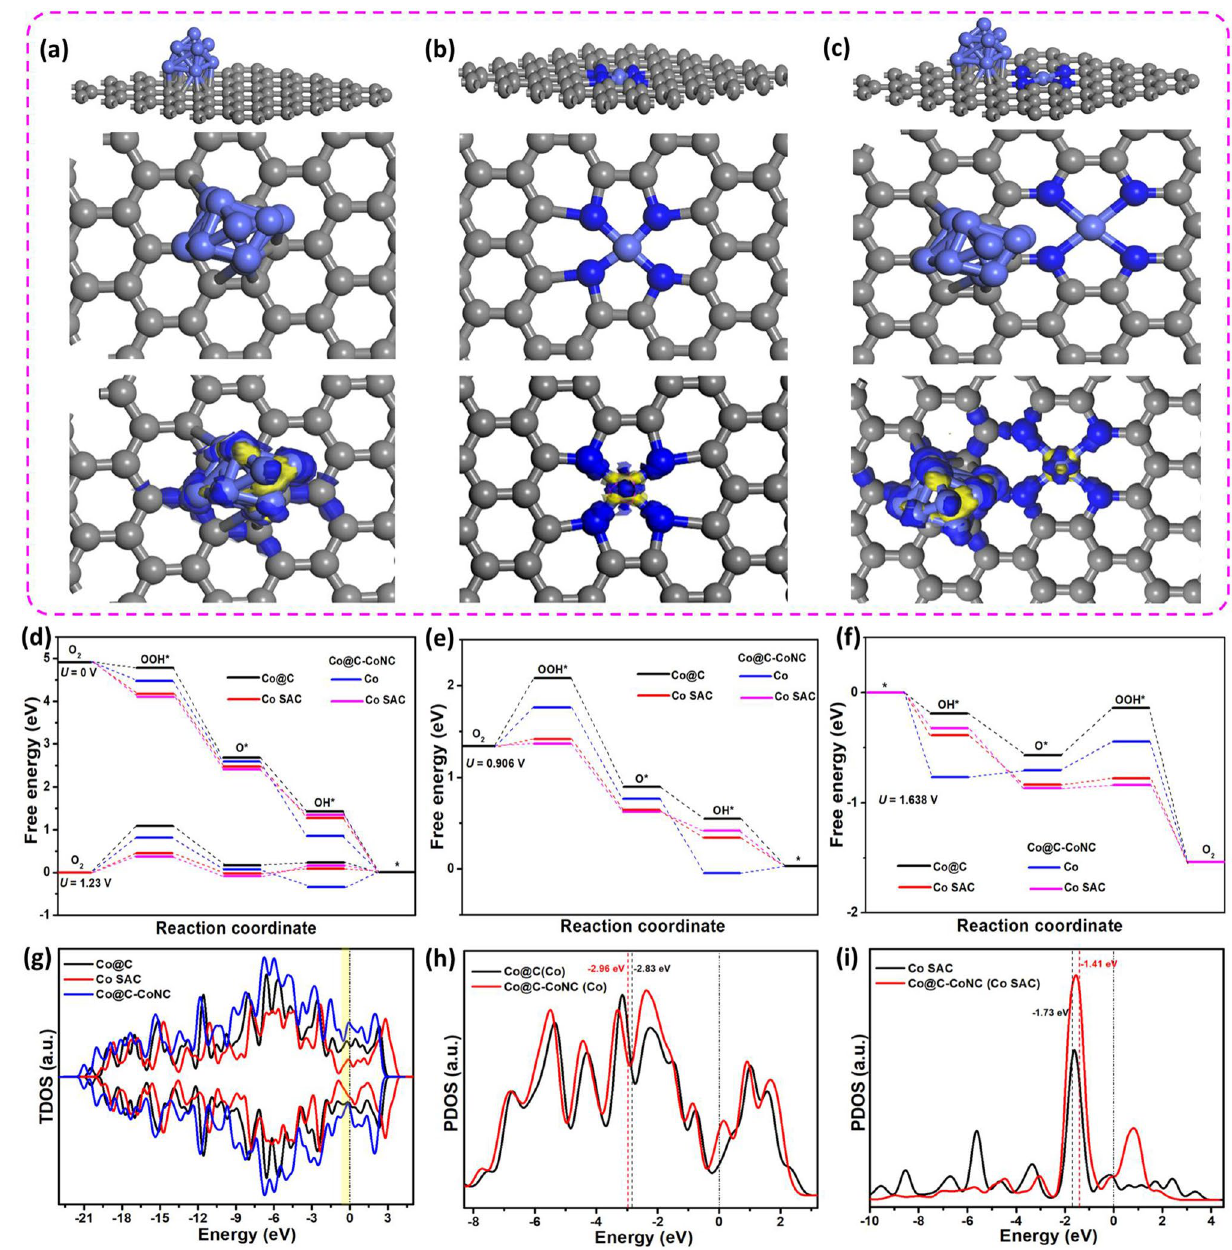
Fig. 7 Atomic models with charge density difference plots for: a Co@C, b Co SAC (i.e., Co-N 4 ), and c Co NP adjacent to Co SACs in Co@C- CoNC, in which the yellow and blue regions represent electron accumulation and depleted regions, respectively; d‑f Free energy diagrams for ORR and OER, in which the black lines represent Co NP in bare Co@C, red lines represent Co SAC in Co-N 4 , and the blue and magenta lines represent the Co NP and the adjacent Co SACs in Co@C-CoNC; g‑i Total and projected electron density of states (on d orbitals of Co) for bare Co@C, Co SAC and Co@C-CoNC